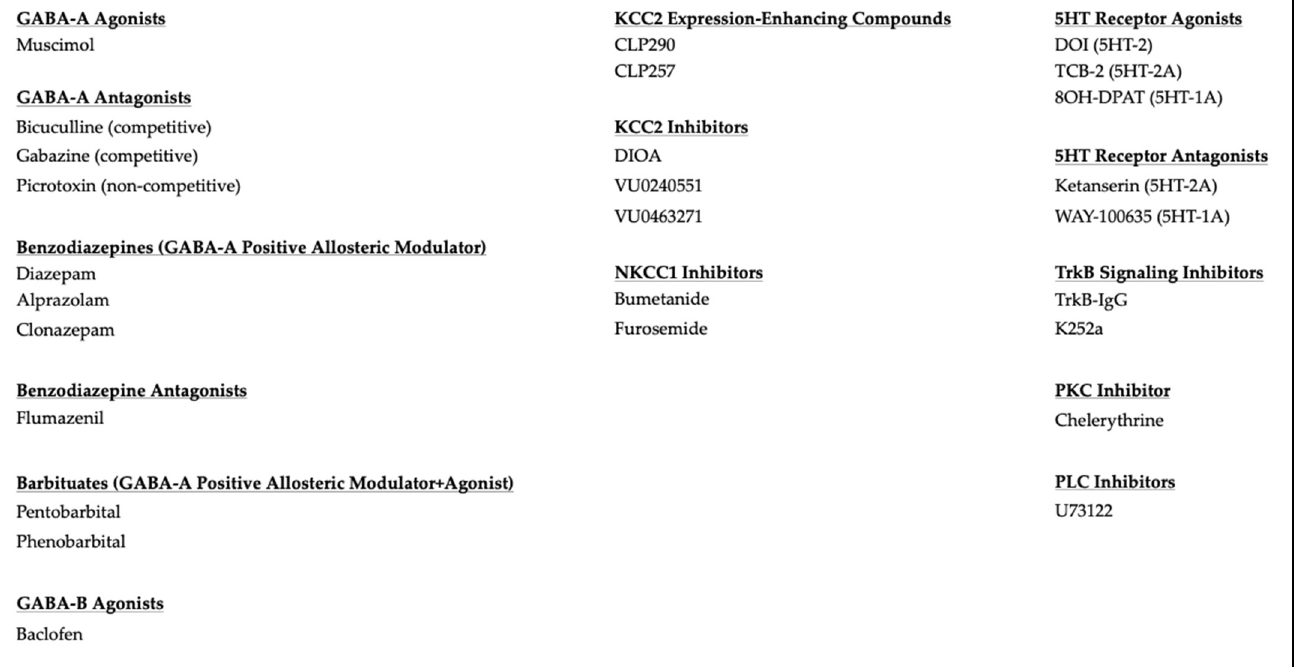
Figure 2. Drugs used to target GABA functionality and ionic plasticity.